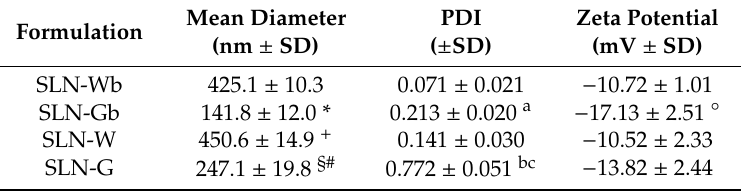
Table 5. Average particle size, PDI and zeta potential of prepared solid lipid nanoparticles (SLNs). Results are expressed as mean ± SD.